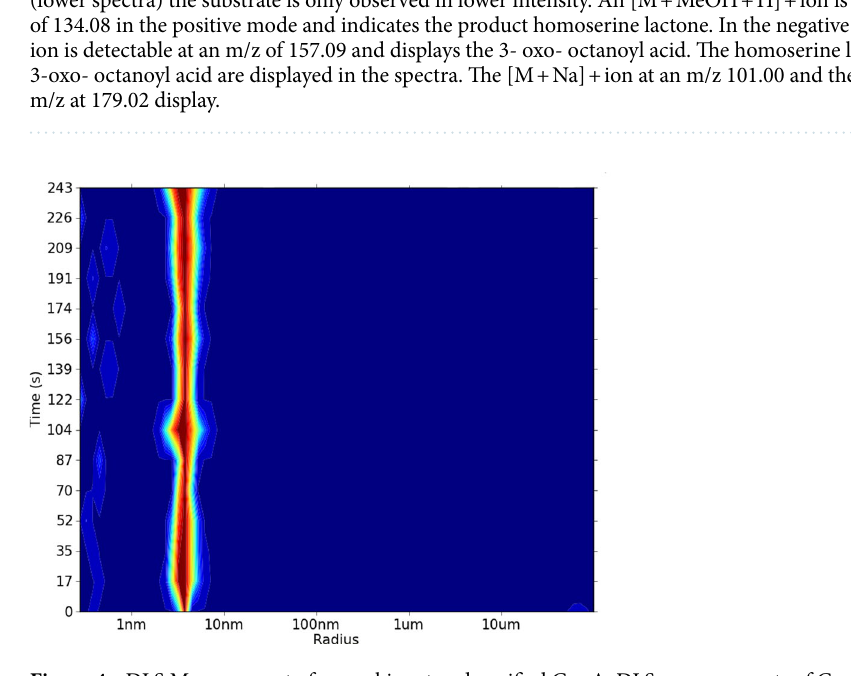
Figure 4. DLS Measurement of recombinant and purified GqqA. DLS measurements of GqqA (3.6 mg ml −1 ) revealed a hydrodynamic radius of 3.9 ± 0.1 nm, corresponding to a GqqA dimer (approx. 61 kDa). The relative abundancy of particles is color-coded from dark blue (low) to dark red